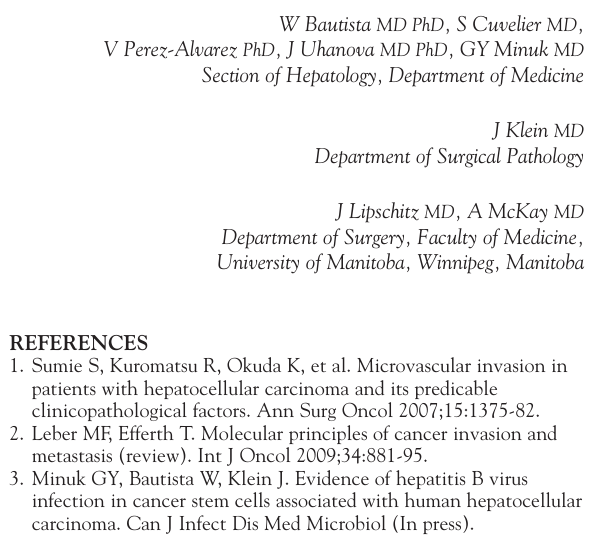
Table 1 Prevalence and distribution of cancer stem cells (CSC) in hepatocellular carcinoma (HCC) with microvascular invasion